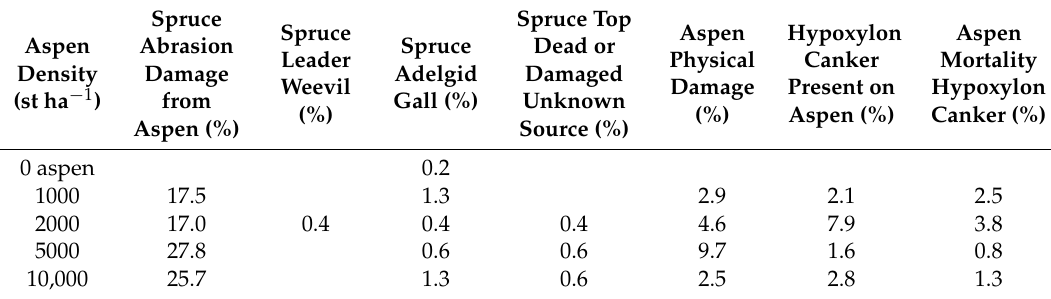
Table 3. Summary of damaging agents to white spruce and aspen at Siphon Creek in 2010.